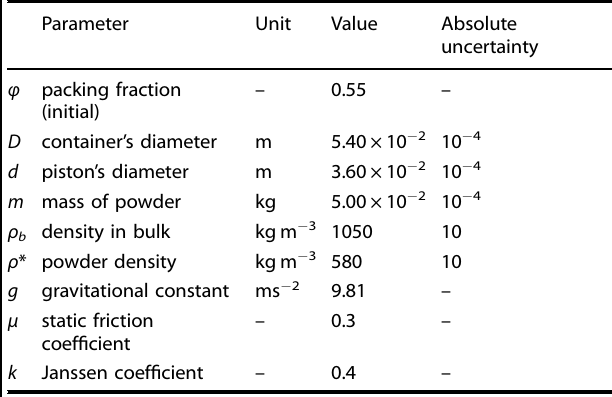
Table 2. Numerical values of the parameters describing our system: a polystyrene powder in a polycarbonate